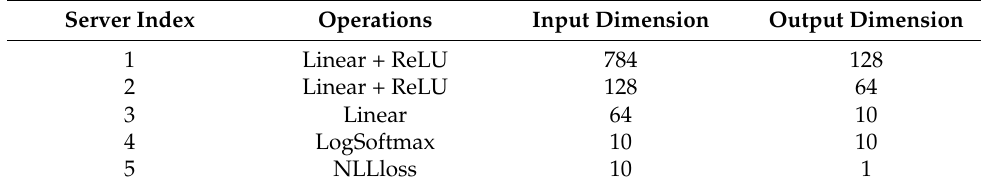
Table 1. The configuration of MLP in decentralized